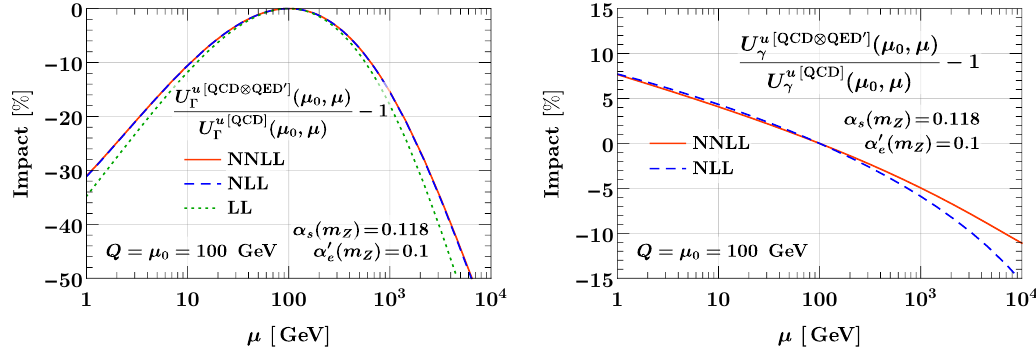
Figure 12 . Same as (cid:12)gure 11, but for a toy QED 0 with (cid:11) 0 accuracy or including EW radiation. In other words, systematic integration errors that are typically assumed to be subleading cannot be overlooked when attempting percent- level